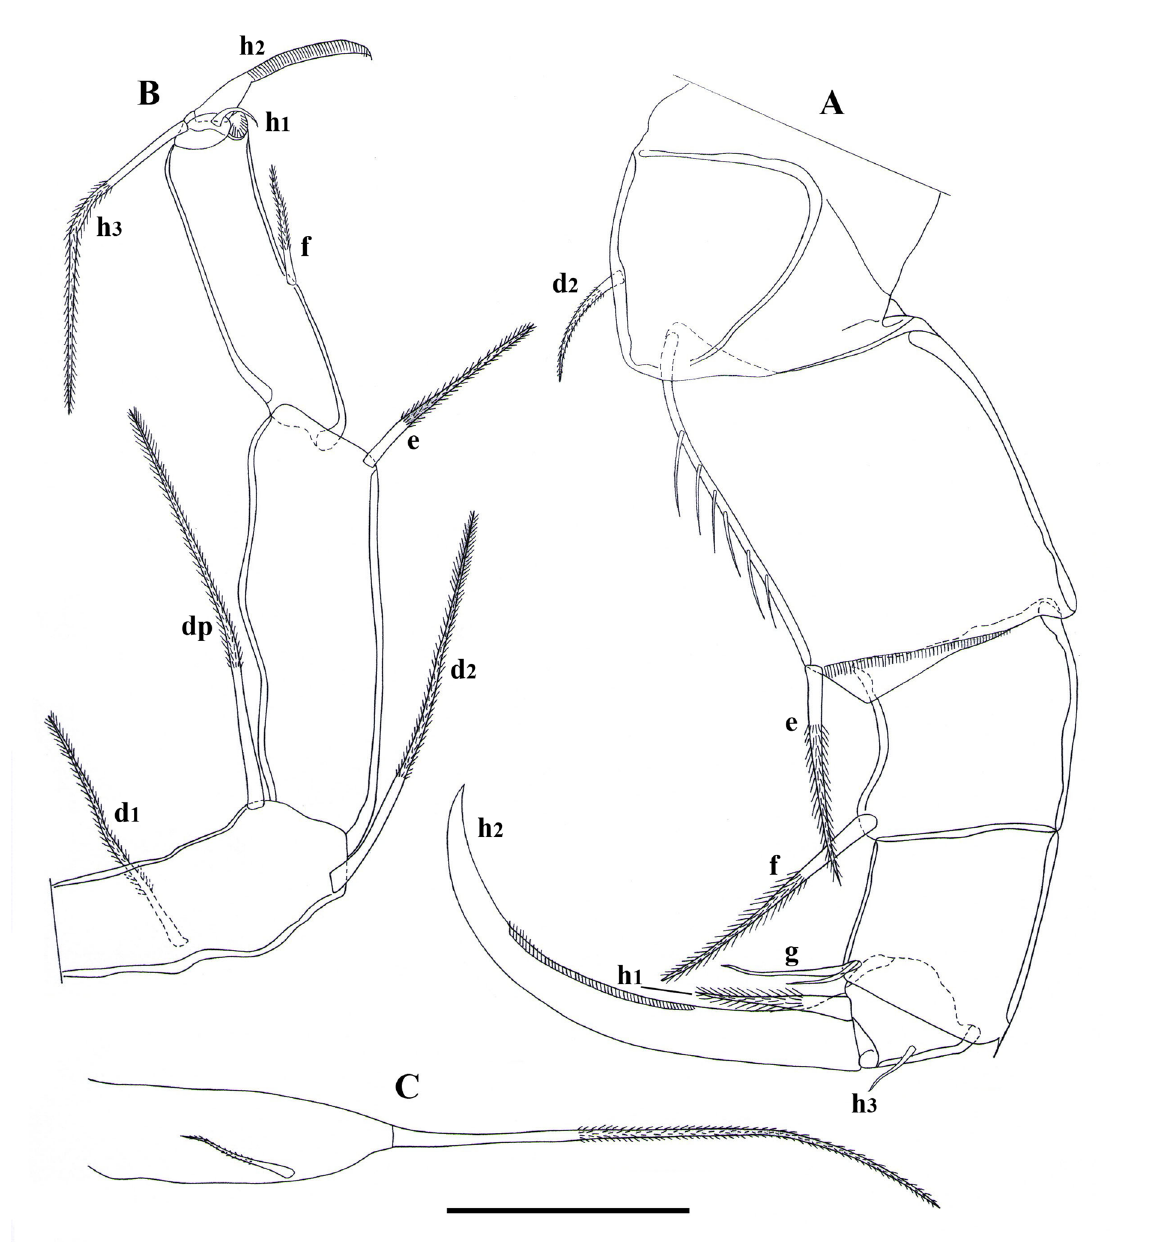
Fig. 14. Siamopsis khoratensis gen. et sp. nov., ♀ (MSU-ZOC.204). A . T2. B . T3. C . CR. Scale bar: 50